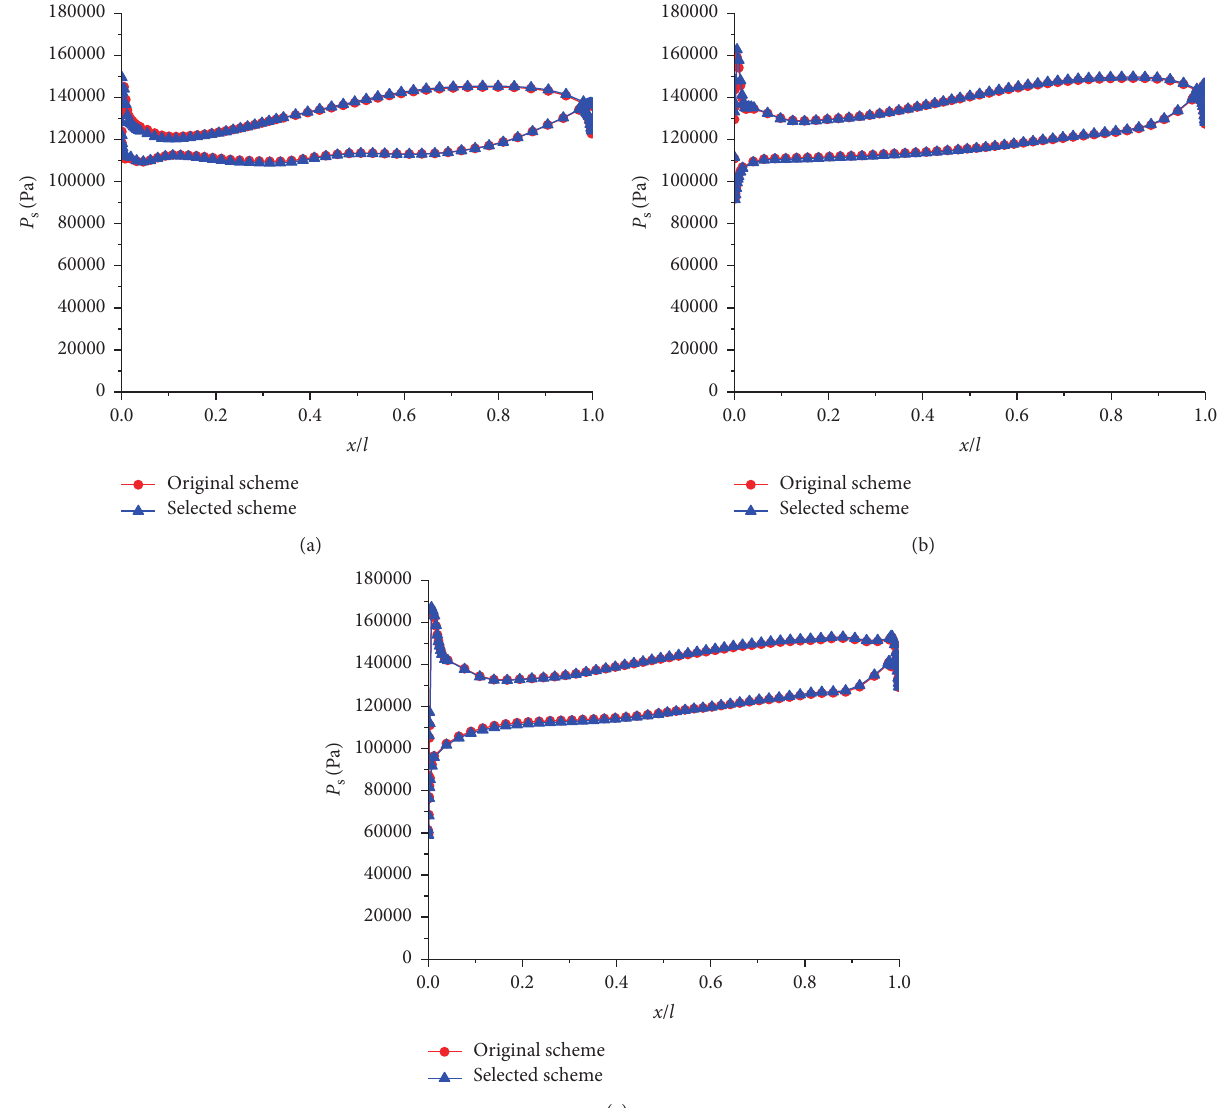
Figure 16: Static pressure distribution on each span under 1.0 Q ′ condition: (a) span � 0.1; (b) span � 0.65; (c) span �